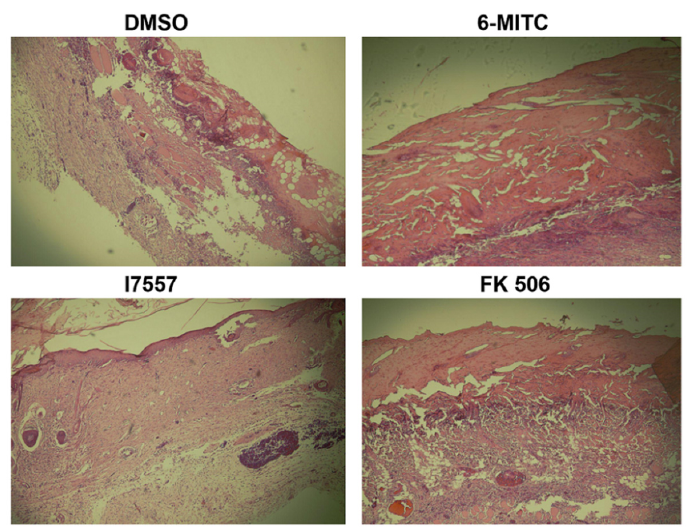
Figure 7. 6-MITC and I7557 reduce the inflammatory reaction with improved integrity of the epi- dermis and less marked inflammatory cell infiltration compared with the DMSO vehicle controls. Magnification